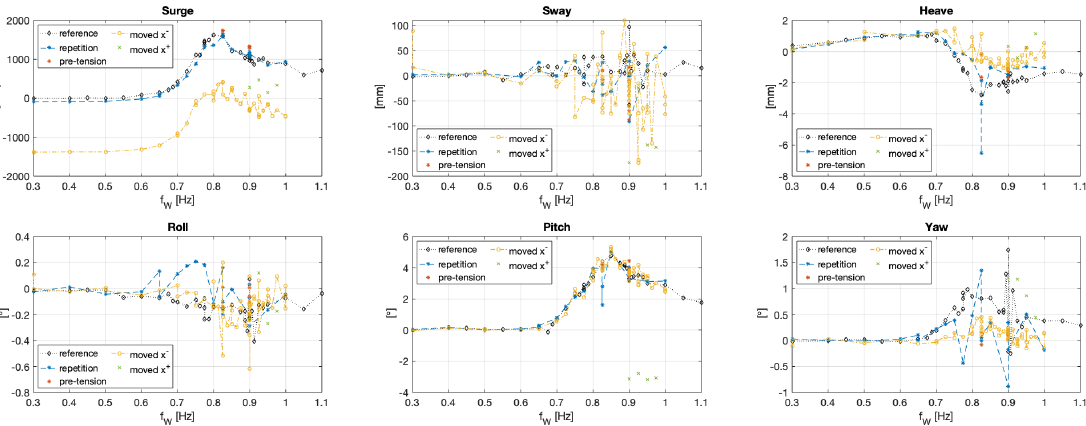
Figure 4. Average value of the repeat time for all DoF—the reference measurement uses data from Gabl et al. [1] and is compared to the repetition of those experiments as well as changes of the pretension and different initial position in the